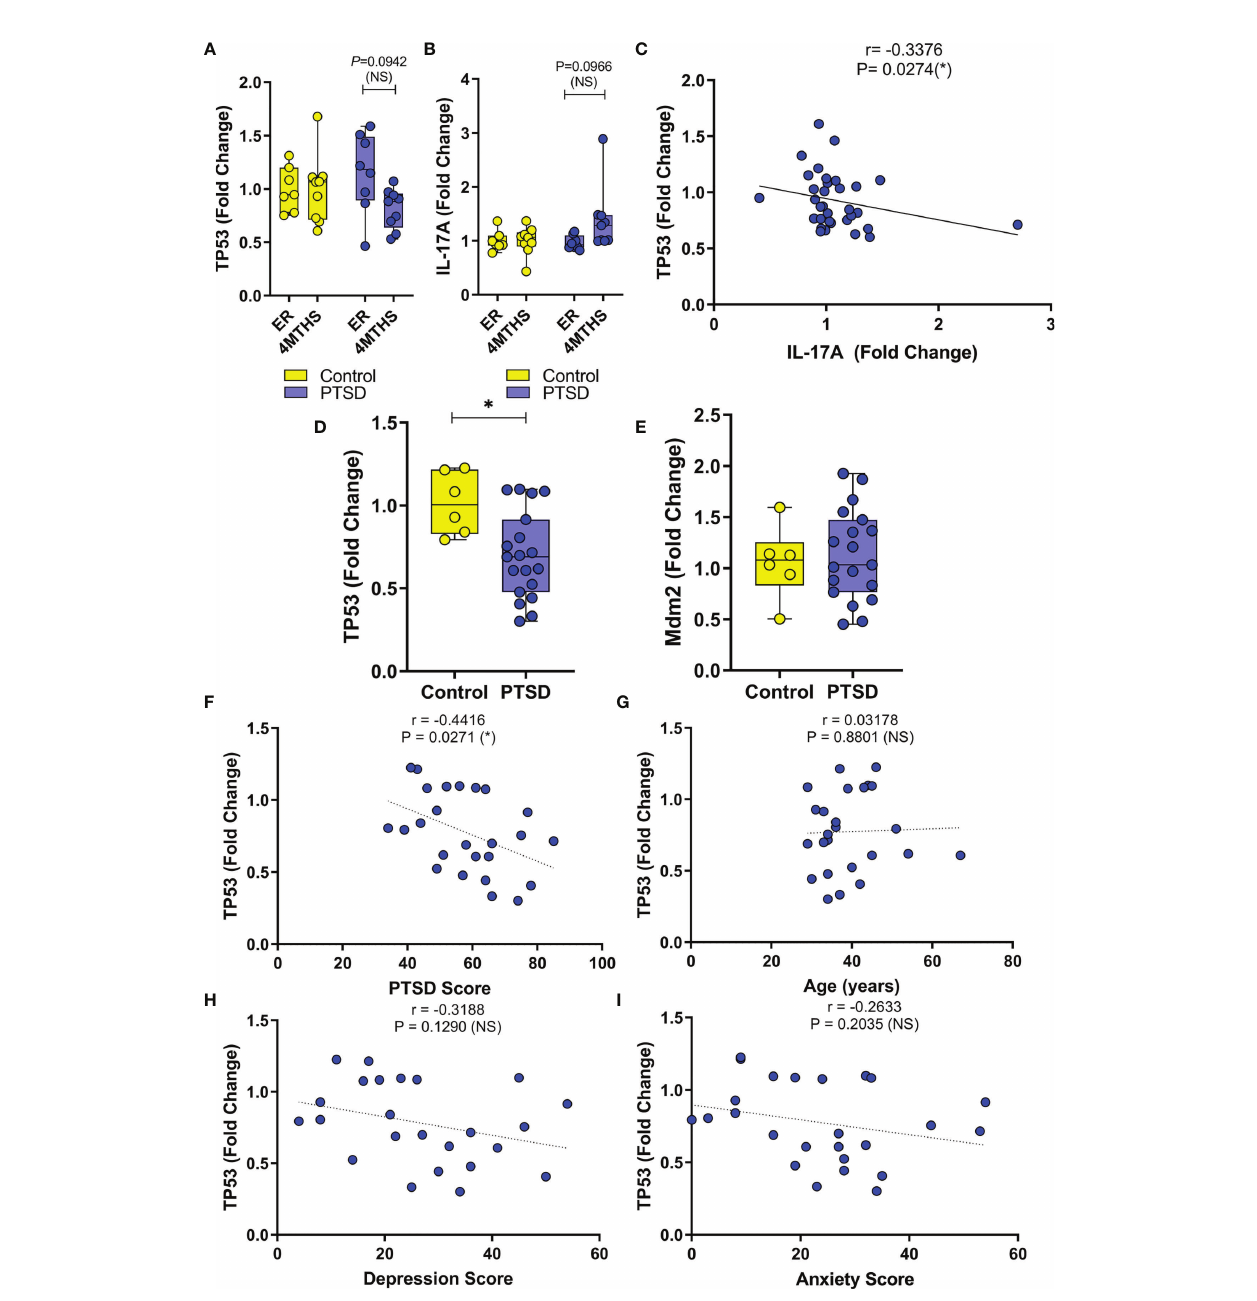
FIGURE 3 | Expression of TP53 in PBMCs is downregulated in PTSD samples compared to Control. (A – C) Normalized expression data was analyzed from public database (ID. GSE860) between PTSD (n=17) and Controls (n=15), with two time points during initial emergency room visit for trauma (ER) and 4 months later (4MTHS). (A) Box and whisker plot depicting fold change expression of TP53. (B) Box and whisker plot depicting fold change expression of IL-17A. (C) Correlation plot between TP53 and IL-17A fold change expression. (D – I) PBMC gene expression data was collected from VMC PTSD (n=19) and Control volunteers (n=6). (D) Box and whisker plot depicting TP53 expression by PCR. (E) Box and whisker plot depicting Mdm2 expression by PCR. Correlation plots depicting (F) TP53 vs. PTSD score, (G) TP53 vs age of cohort, (H) TP53 vs. Depression score, and (I) TP53 vs. Anxiety score. Box and whisker bars depict maximum and minimum values, with middle bar depicted at the median. For box and whisker plots, signi fi cance was determined using an unpaired standard t test. For correlation plots, Pearson correlation test was used to determine signi fi cance. Signi fi cance was de fi ned as having p-value ≤ 0.05